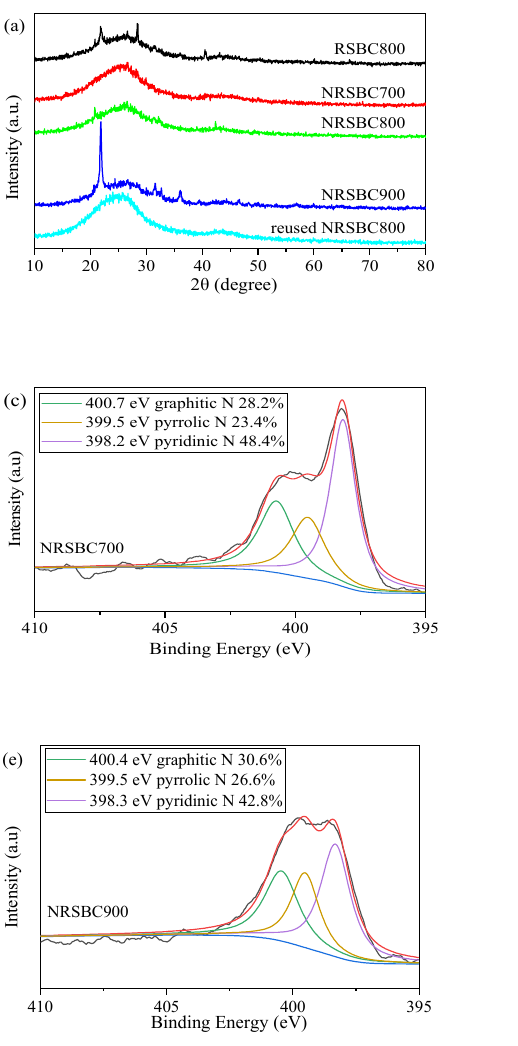
Figure 2. XRD patterns ( a ) and Raman spectra ( b ) of different materials (RSBC800, NRSBC700, NRSBC800, NRSBC900 and reused NRSBC800); N1s spectrum of NRSBC700 ( c ), NRSBC800 ( d ), NRSBC900 ( e ) and reused NRSBC800 ( f ).